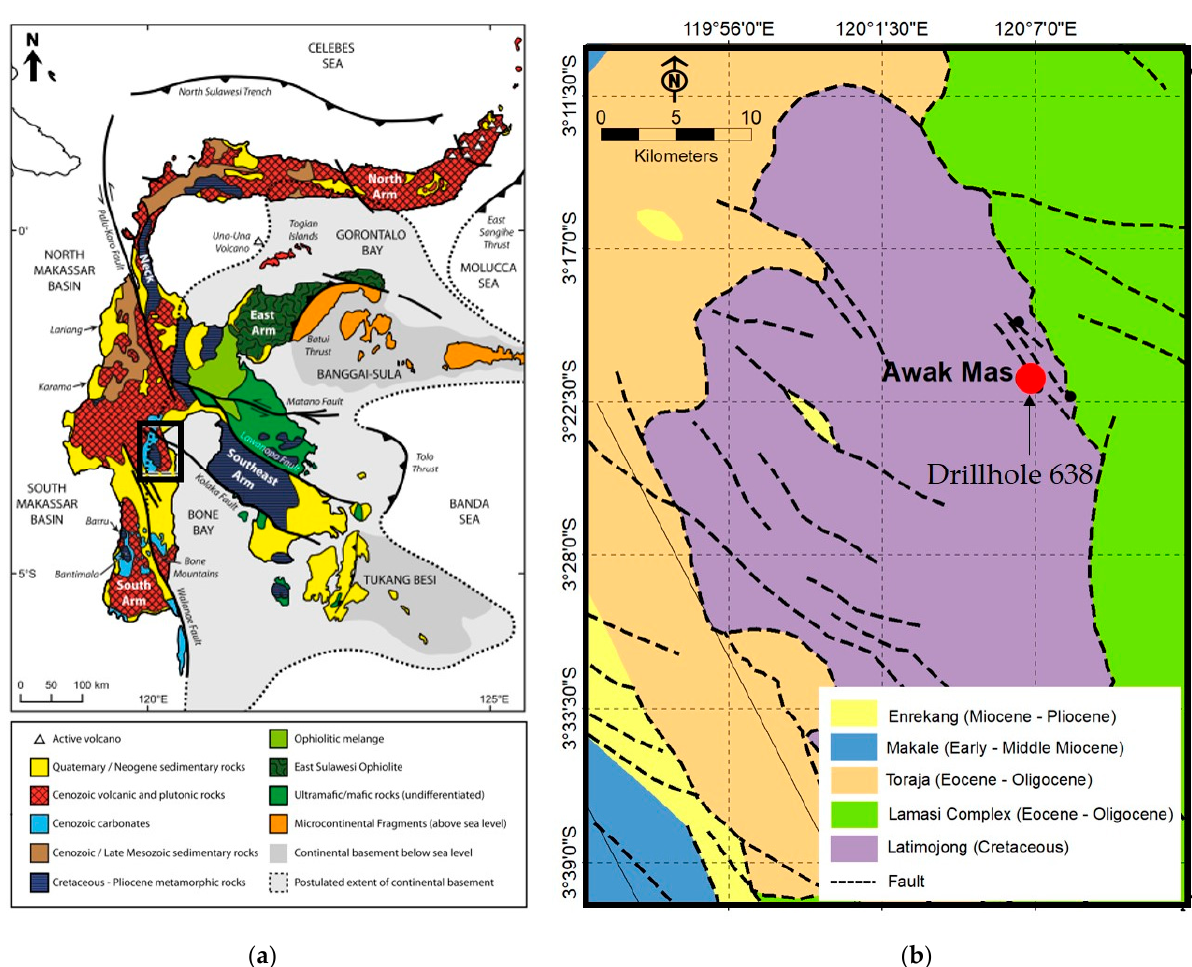
Figure 1. ( a ) Geology of Sulawesi Island, modified from [12], where the location of study area is shown by the black rectangle, ( b ) Geology of Awak Mas gold deposit, modified from [16–18]. The drillhole 638 location is shown by the red dot.